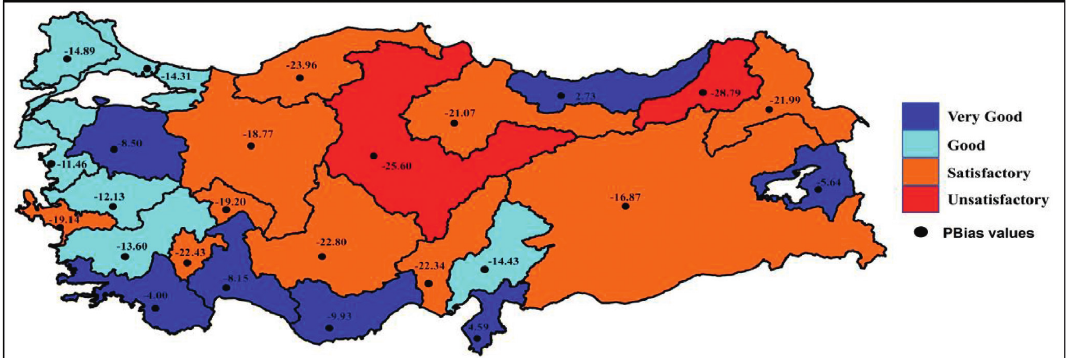
Figure 6: Results of PBias evaluation for TRMM data.